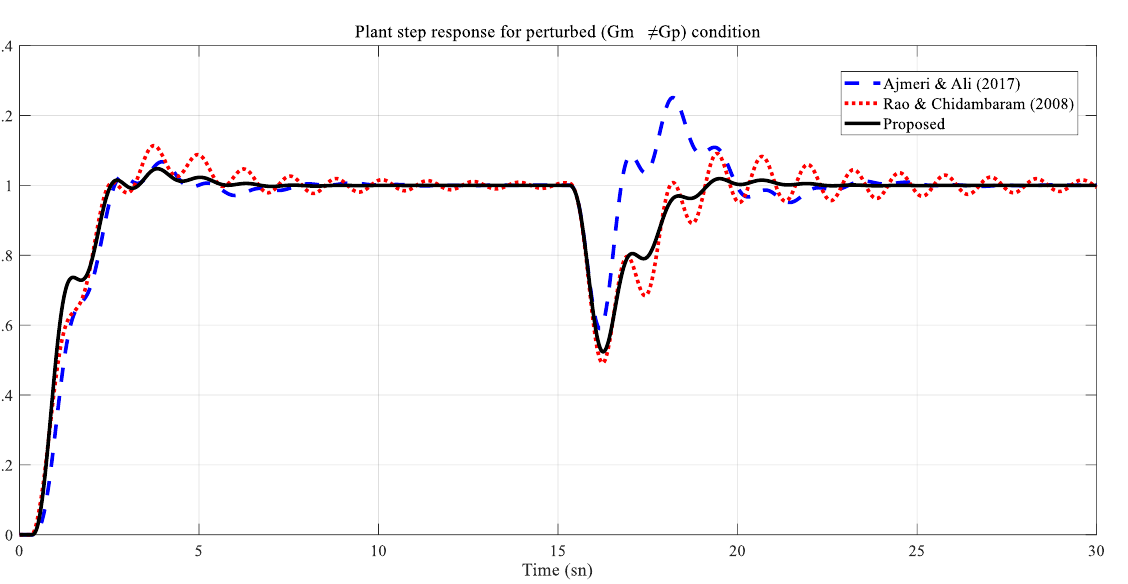
Figure 6. Performance comparison of the proposed method and other methods, in terms of parameter changes, for Example 1 [15,18]. Table 3. IAE performance measures for Example